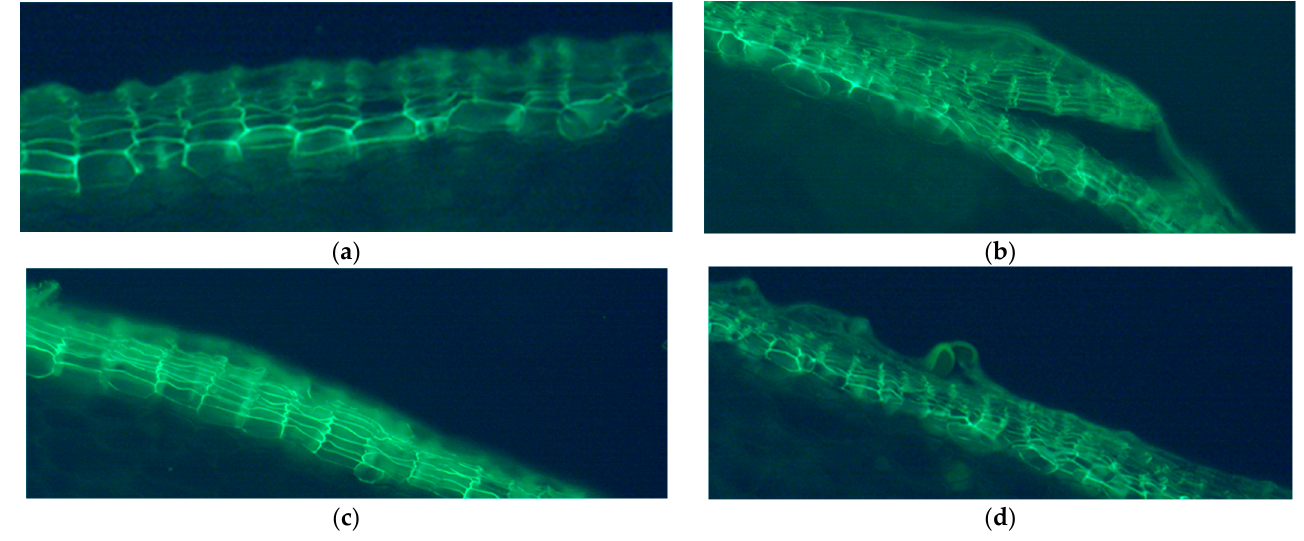
Figure 4. Representative samples of suberized cell layers in the ( a ) normal (N) skin, as well as the three defected skin types, including ( b ) surface cracking (SC), ( c ) silver patch (SP), and ( d ) russeting (R) of Dark Red Norland tubers under fluorescence. Photos were taken by Manlin Jiang using Leica LAS X Imaging and Analysis Software.